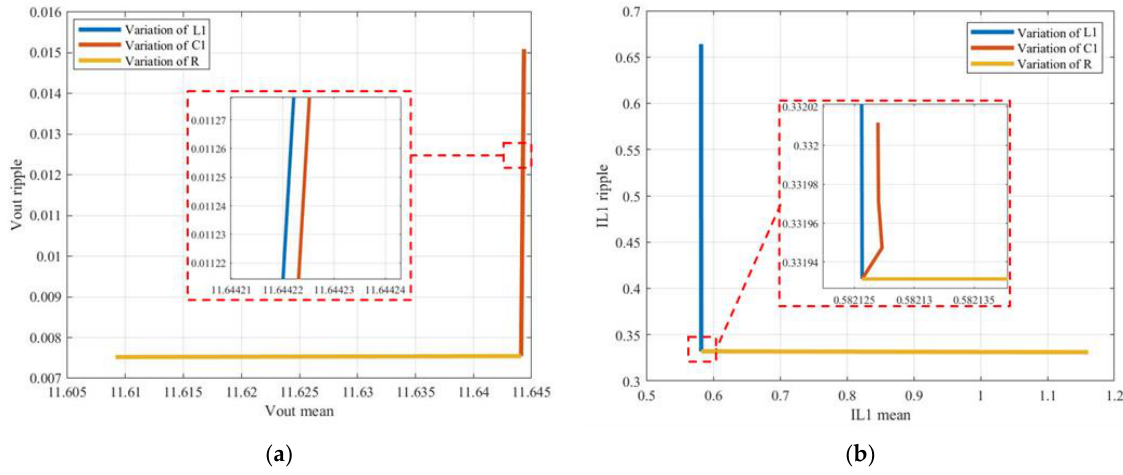
Figure 8. Testability curves during the switch-on period: ( a ) variations introduced in the output voltage; ( b ) variations introduced in the inductor